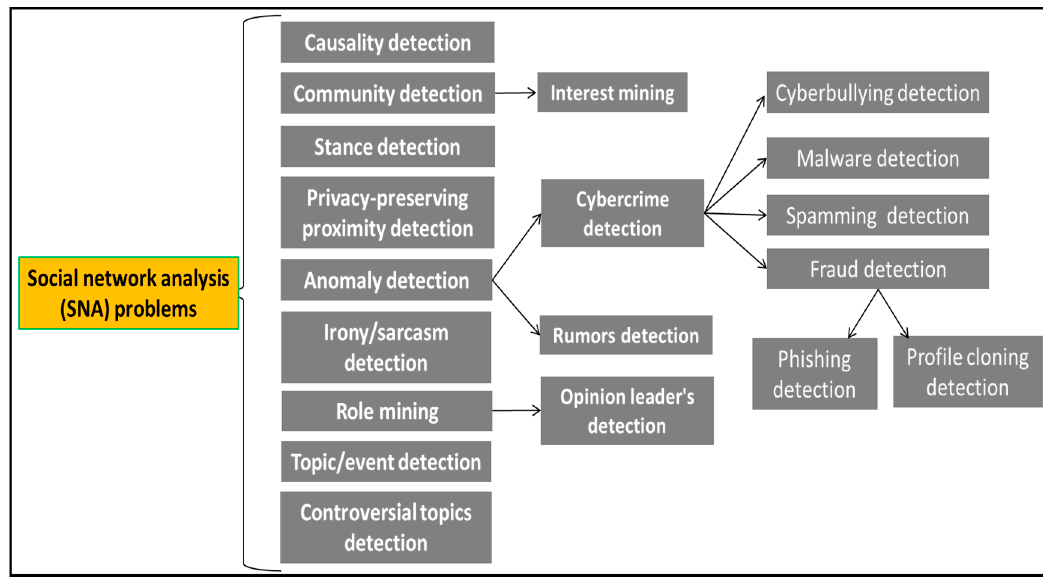
Figure 48. Taxonomy of the online social networks (OSNs) analysis problems (Ref. [157]).